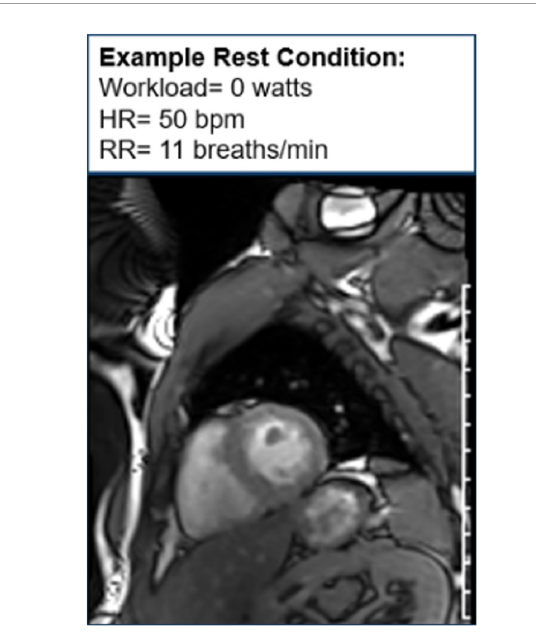
FIGURE12 Cine image during exercise. One image of cine loop at the end short-axis view of the myocardium. The left ventricle is gray, while the blood pool is white. During exercise, the workload is 110 w, and the patient’s heart rate is 101 bpm and respiratory rate is 21 breaths/min.